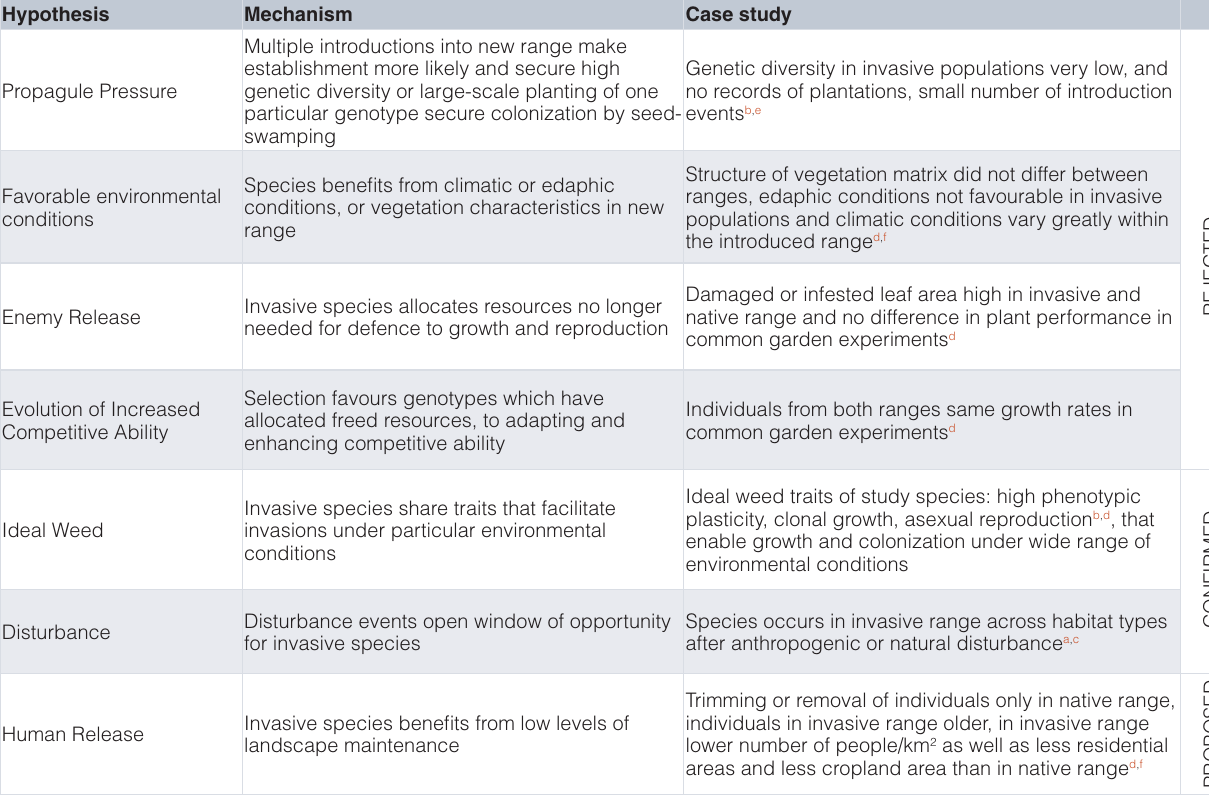
Table 1. Incremental approach to identify the most influential mechanisms for the invasion success of Rosa rubiginosa in Argentina. ( a Cavallero & Raffaele 2010, b Zimmermann et al. 2010, c 2011, d 2012, e Hirsch et al. 2011, f present publication).